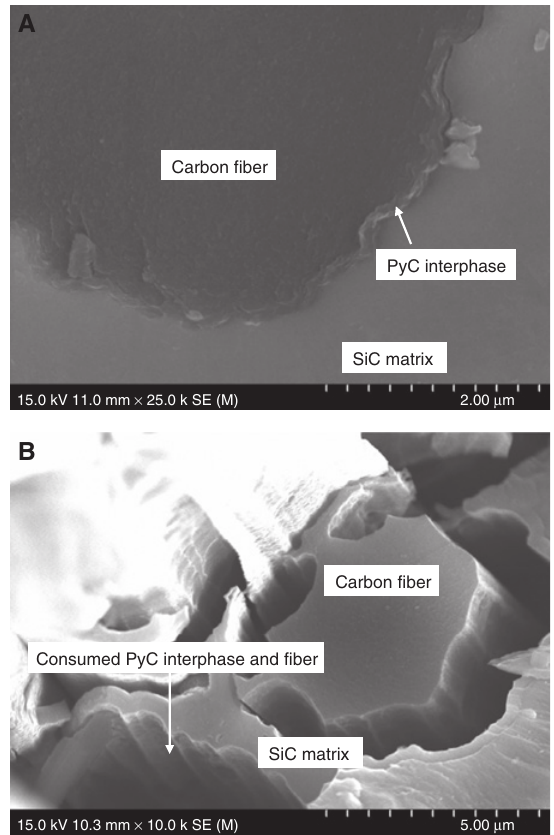
Figure 4 The EDS analysis of oxidized SiC coating at different